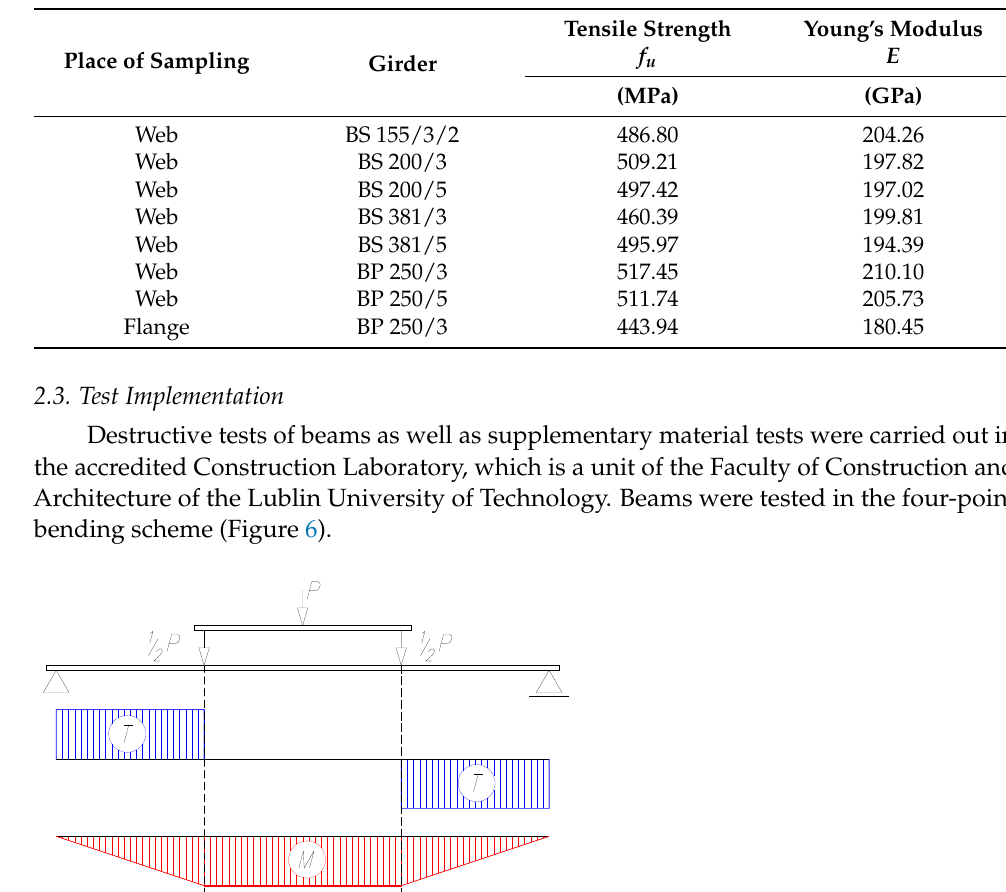
Table 2. Material characteristics of girder steels.